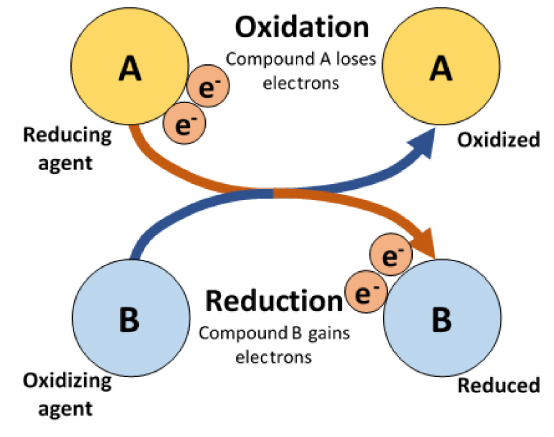
Figure 4. Oxidation and